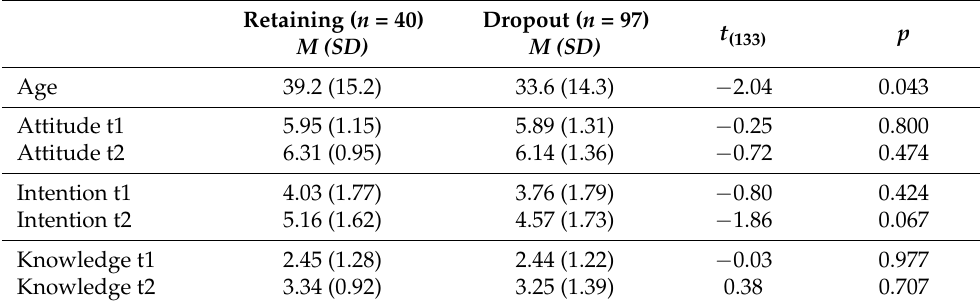
Table 1. Results of the dropout analysis (participants who dropped out between t2 and t3).